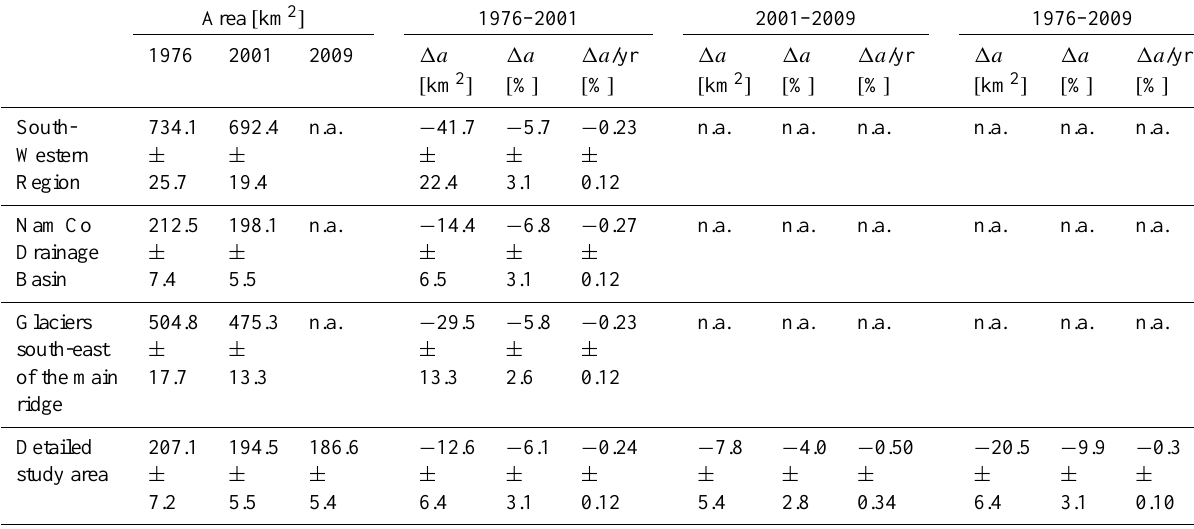
Table 4. Change in glacier area 1976-2001-2009.